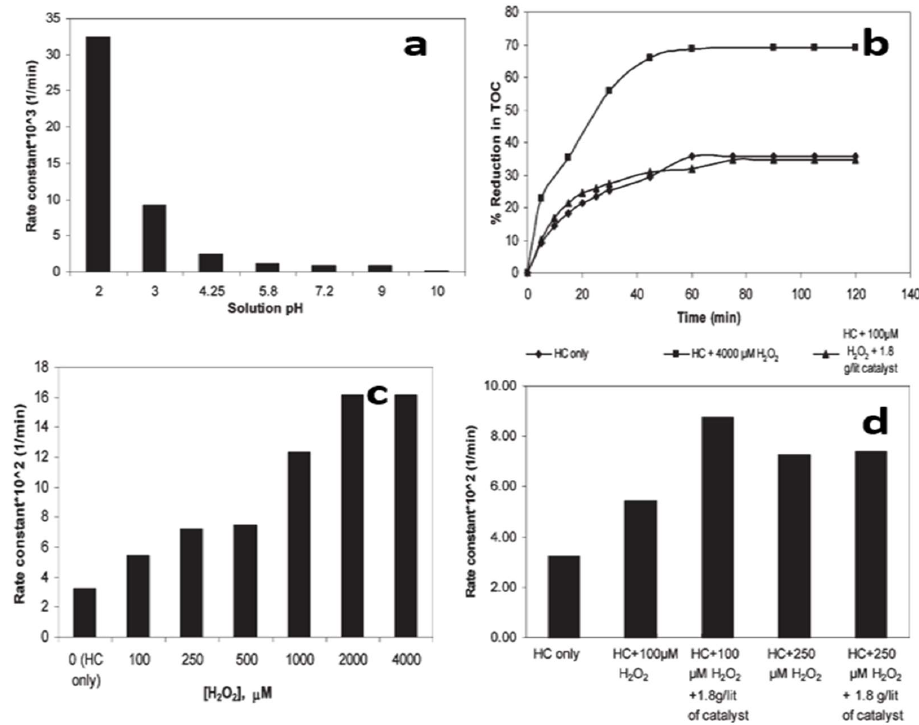
Figure 8. ( a ) Effects of solution pH on the decolorization rate of AR88. Conditions: volume of solution, 4 L; initial concentration, 100 µM; inlet pressure, 5 bar. ( b ) Reduction (%) in TOC as a function of time under different optimized conditions: volume of solution, 4 L; initial concentration, 100 µM; pH of the solution, 2.0; inlet pressure, 5 bar, ( c ) Effects of H 2 O 2 addition on the decolorization rate of AR88. Conditions: volume of solution, 4 L; initial concentration, 100 µM; pH of the solution, 2.0; inlet pressure, 5 bar. ( d ) Effects of catalyst addition on the decolorization rate of AR88. Conditions: volume of solution, 4 L; initial concentration, 100 µM; pH of the solution, 2.0; inlet pressure, 5 bar. Adapted from reference [204].